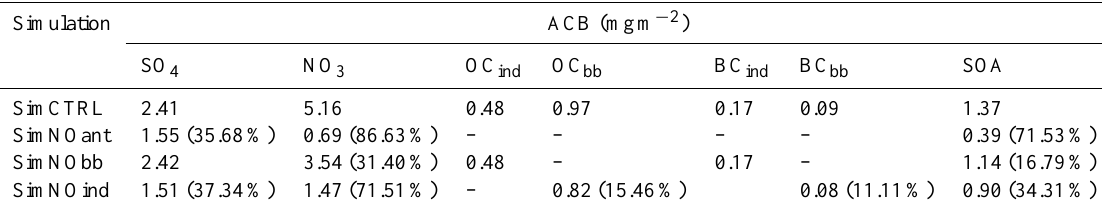
Table 1. Global annual average of aerosol column burden (ACB, mgm − 2 ) as simulated by NASA ModelE2-YIBs in the control and sensi- tivity present-day simulations for, in order, sulfates, nitrates, organic (OC) and black carbon (BC) from industrial (ind) and biomass burning (bb), and secondary organic aerosols (SOA). Cases filled with “–” refer to negligible values of ACB (i.e., order of magnitude pgm − 2 ). For sensitivity simulations, percentage values in parentheses indicate the contribution of target emissions (i.e., anthropogenic, biomass burning, and non-biomass burning) to each aerosol component.